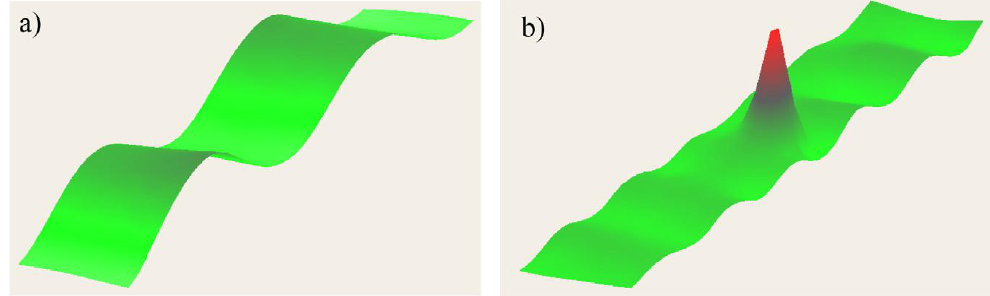
Figure 15. Vibration patterns at the GFRP specimen at 3.4 kHz ( a ) and at the LDR frequency, 20.9 kHz, on a GFRP sample ( b ), with permission from 118.